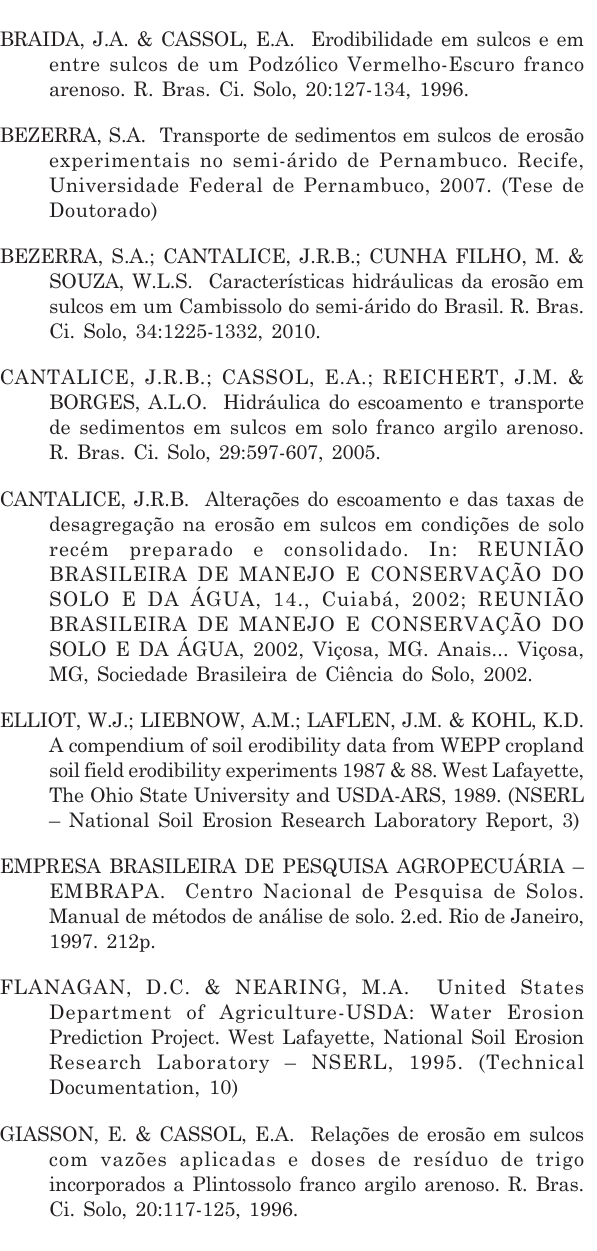
argiloarenoso.Figura 5. Comportamento da erodibilidade (K r ) do Latossolo argiloarenoso em